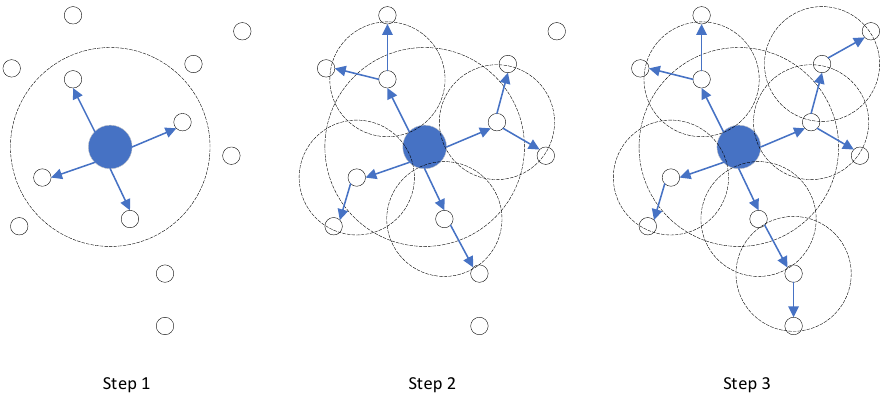
Figure 2. Depth broadcasting process.